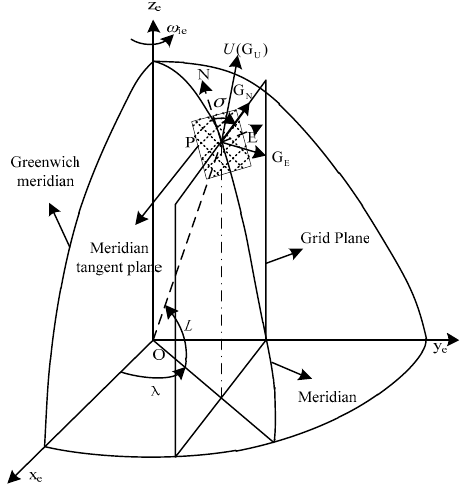
Figure 1. The description of the grid frame.